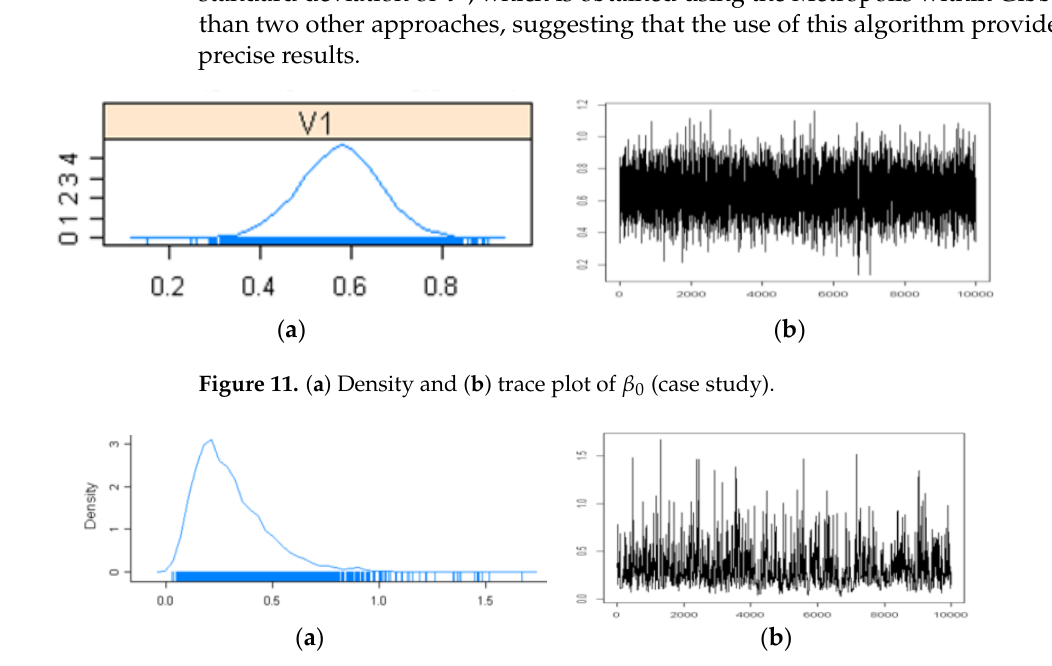
Table 11. Parameter estimates  0 (intercept) and  2 given by Stevens and Taylor [5] ; obtained by the use of the Gibbs sampler algorithm and by the use of the Metropolis within Gibbs (case study).